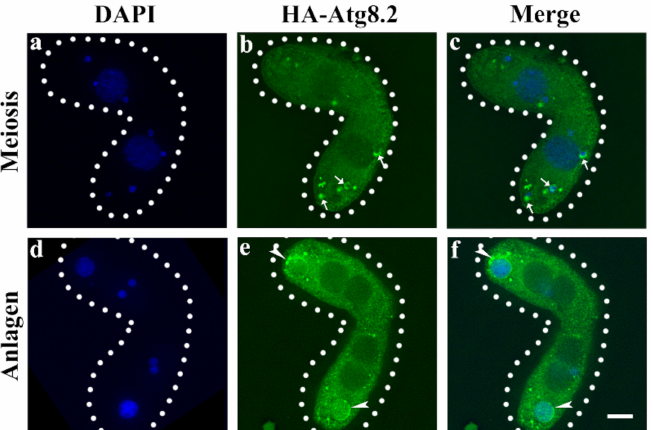
Figure 7. Localization of HA-Atg8.2 in the stage of meiosis and macronuclear anlagen. Cells collected at 5 h and 12 h after mixing were fixed and processed for immunofluorescence staining with anti-HA primary and FITC-conjugated secondary antibodies. Cellular nuclei were stained with DAPI to visualize DNA. ( a , d ), DAPI; ( b , e ), FITC; ( c , f ) Merge. The white arrows in ( b ) and ( c ) point to the meiosis products of MIC to be degraded, and the white arrows in ( e , f ) point to the paMAC to be degraded. Dashed circle represents the cell outline of Tetrahymena . Fluorescent images were taken with a DeltaVision deconvolution microscope. Scale bar, 10 µ